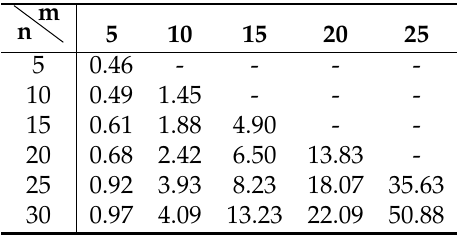
Table A1. Least-squares solution time using Chebyshev polynomials in milliseconds for Problem #1.